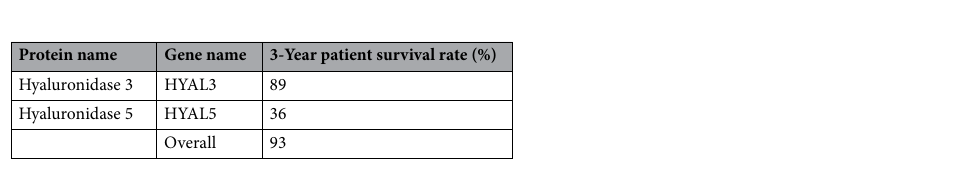
Table 3. Mortality of child fibrosarcoma expressing hyaluronidases and the overall patient cohort 29 .